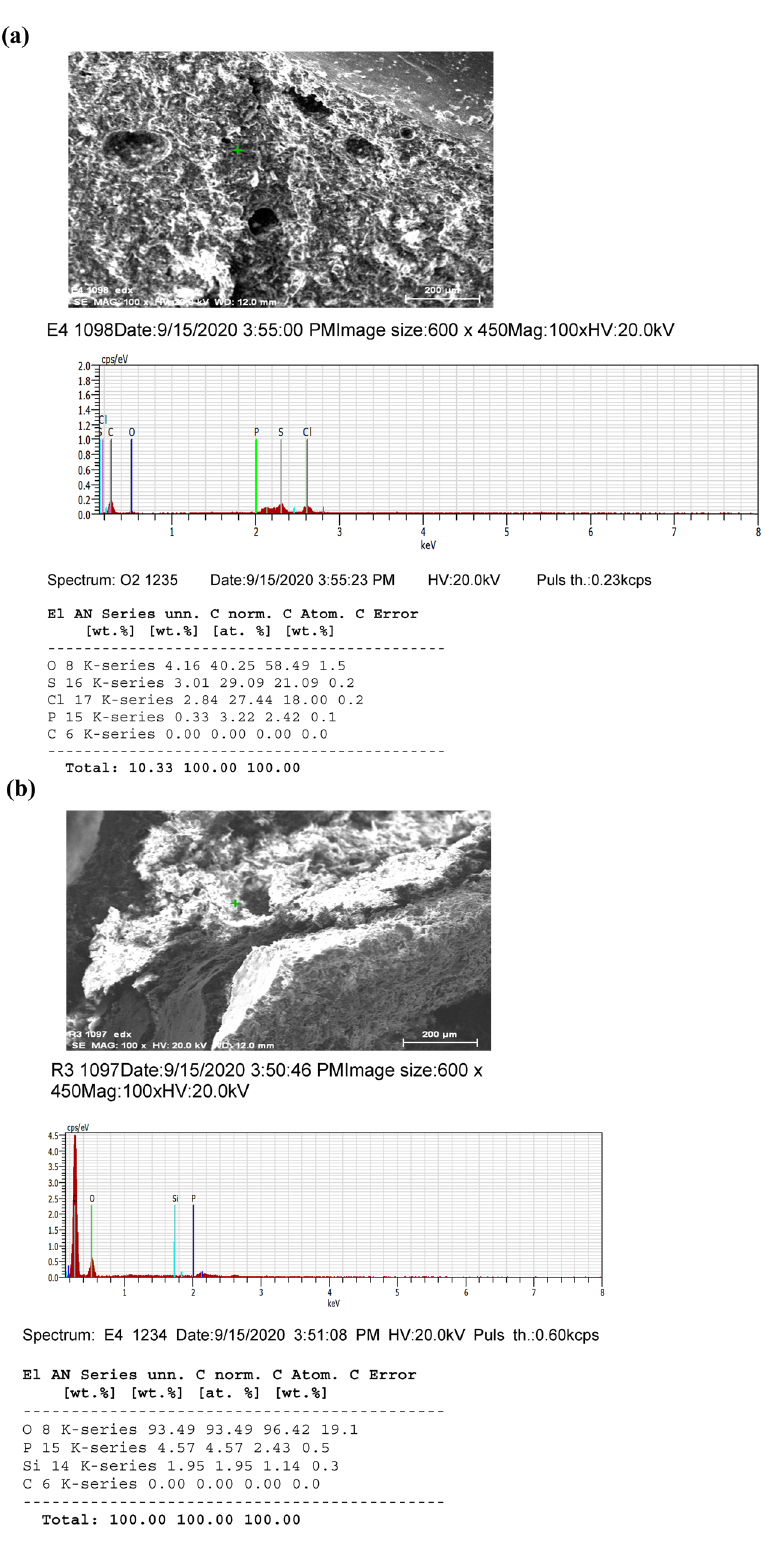
Figure 48: ( a ) SEM – EDAX of the surface of neat recycled EVA polymer without any leather fi bers. ( b ) SEM – EDAX of the surface of leather bu ffi ng dust/recycled EVA polymer